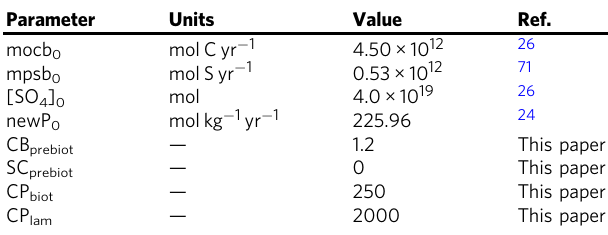
Table 1 Parameters used in the model